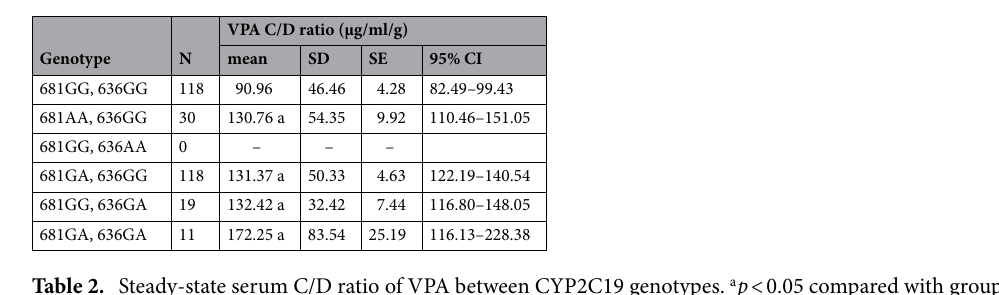
Table 2. Steady-state serum C/D ratio of VPA between CYP2C19 genotypes. a p < 0.05 compared with group (681GG, 636GG).